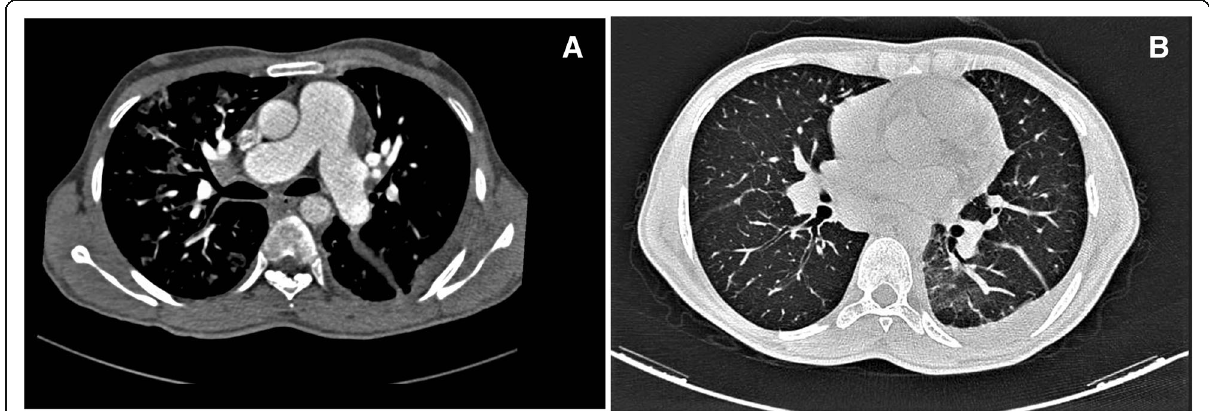
Fig. 1 Computed tomography pulmonary angiogram (CTPA). A Dilated pulmonary trunk (32.2 mm), and right (30.2 mm) and left (30.5 mm) main pulmonary arteries. B Patchy areas of ground glass opacities in the perihilar region of both right and left lower